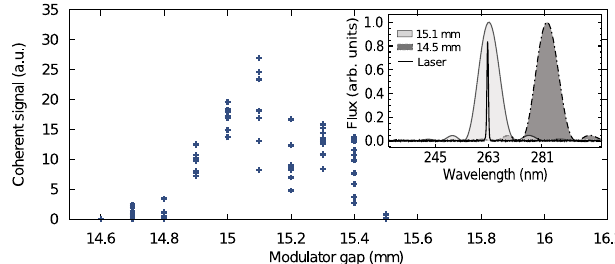
FIG. 8. Coherent signal for different gap settings of the modu- lator. For a given electron energy of 375 MeV the resonance was found at 15.1 mm gap. No energy modulation is observed at 0.6 mm detuning (19.4 nm), which is accompanied by disappear- ing coherent signal. Inset: Overlap of the measured laser spec- trum with calculated spontaneous spectra of the modulator for two different gaps. The seed laser is resonant with a gap of 15.1 mm and off-resonant with a gap of 14.5 mm.